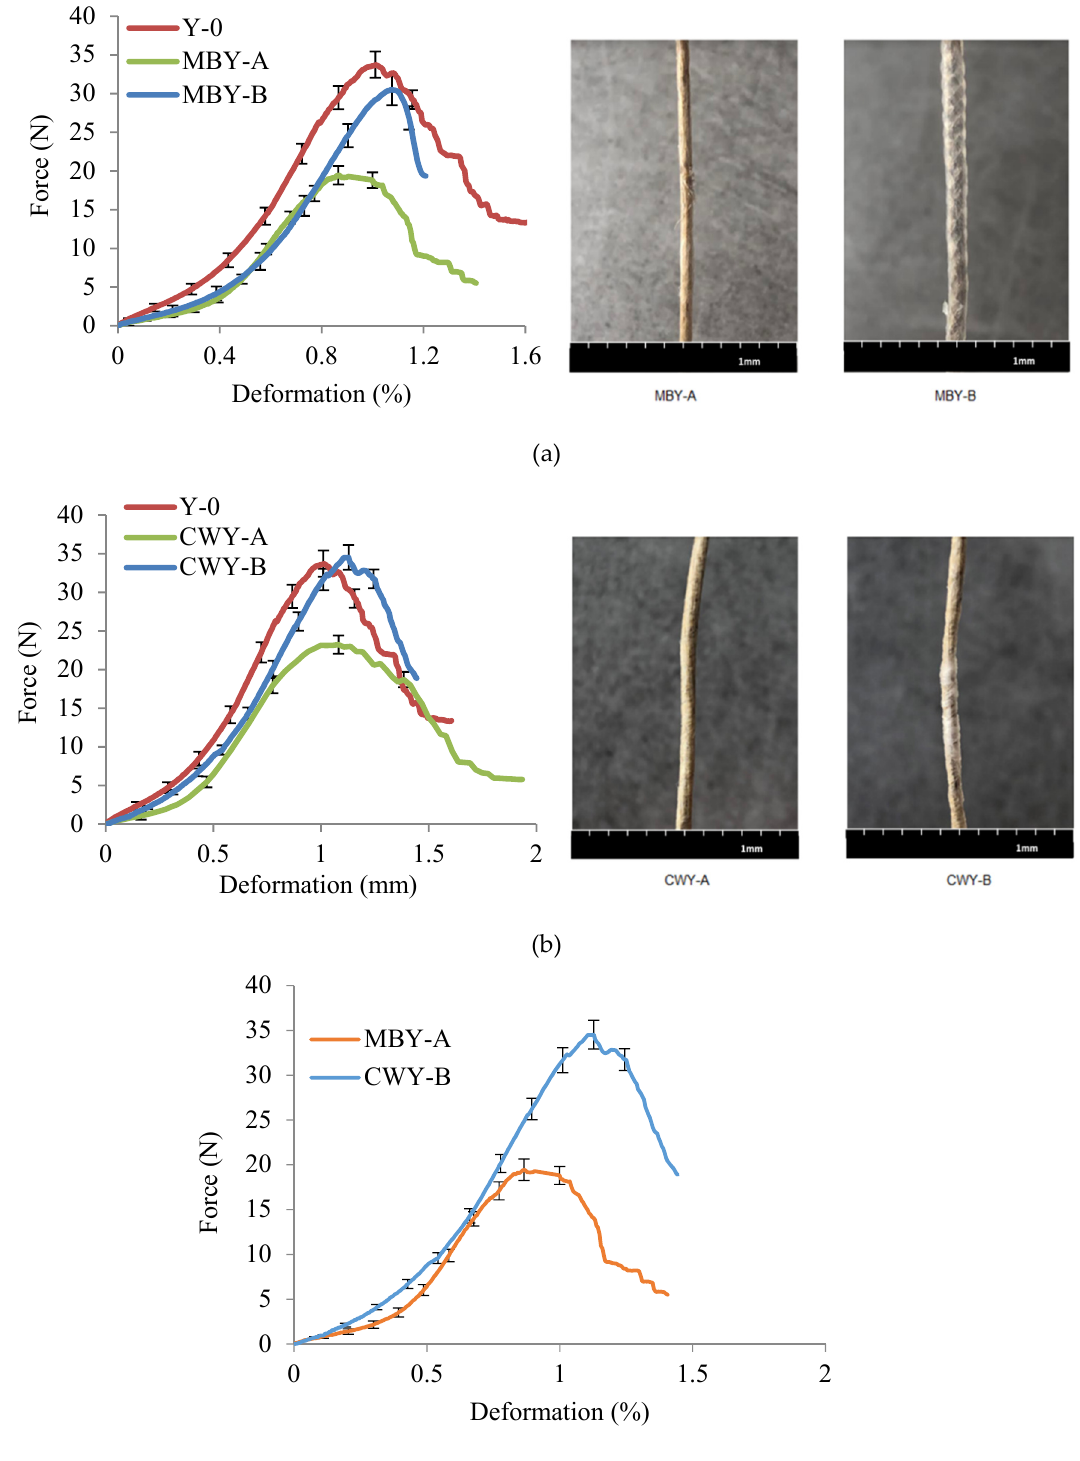
Figure 6. Thermo-state tensile results of ( a ) MBYs vs. Y-0, ( b ) CWYs vs. Y-0, and ( c ) MBY-A vs. CWY-B.